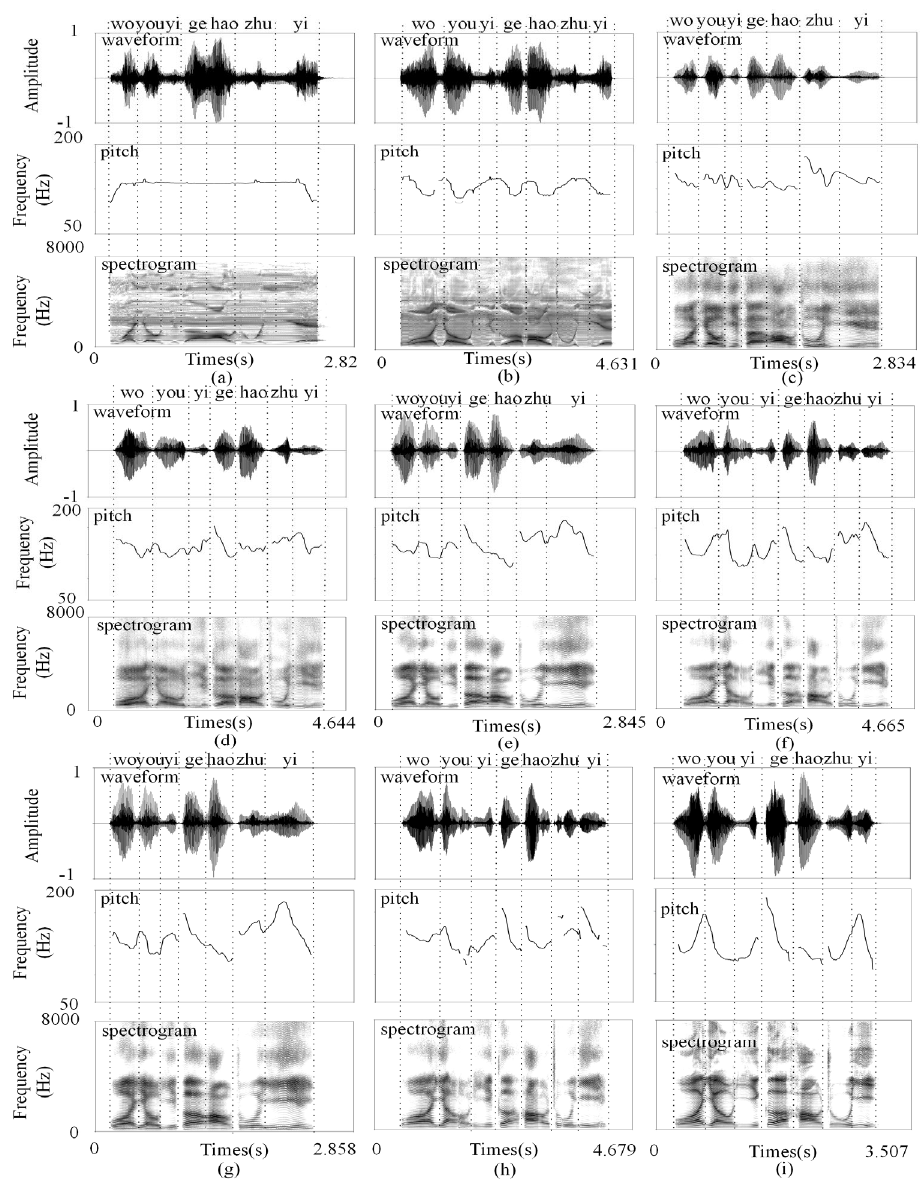
Figure 4. The acoustic features analysis of ( a ) EL-FT speech; ( b ) EL-VT speech; ( c ) CLDNN-FT speech; ( d ) CLDNN-VT speech; ( e ) VC3-FT speech; ( f ) VC3-VT speech; ( g ) 2C1T2C-FT speech; ( h ) 2C1T2C-VT speech; and ( i ) normal speech.